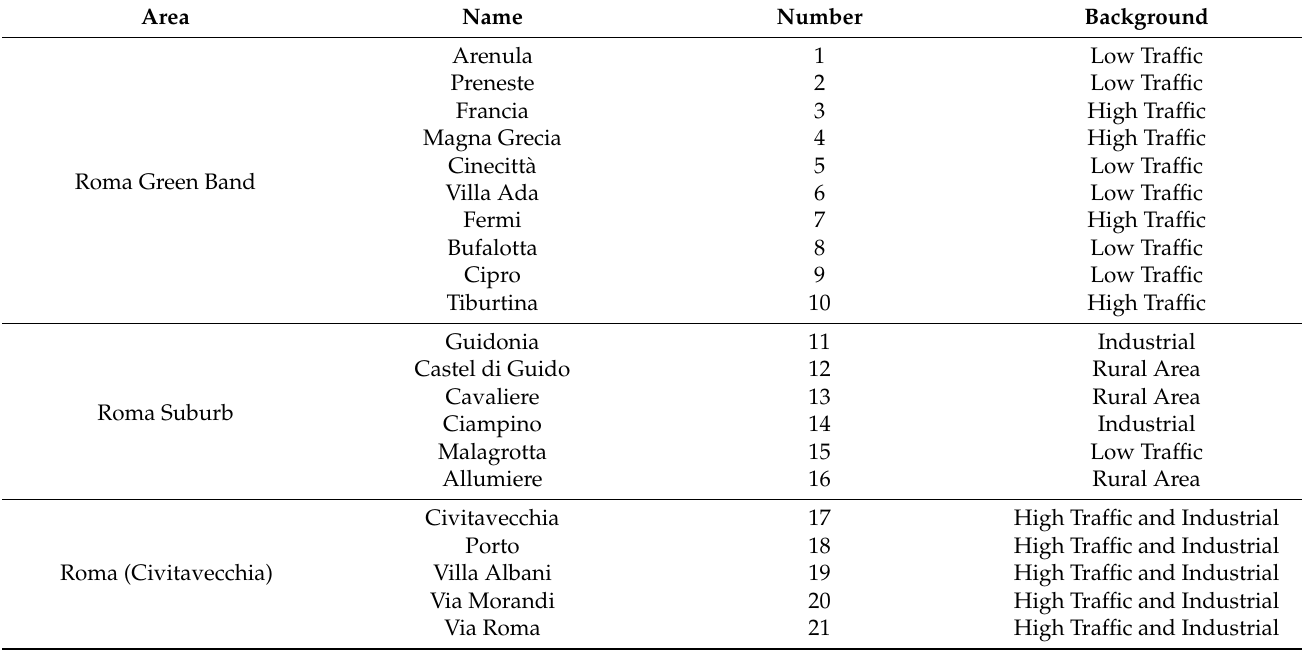
Table 1. Pollutant monitoring stations of Rome center and suburbs used in the present study. Area